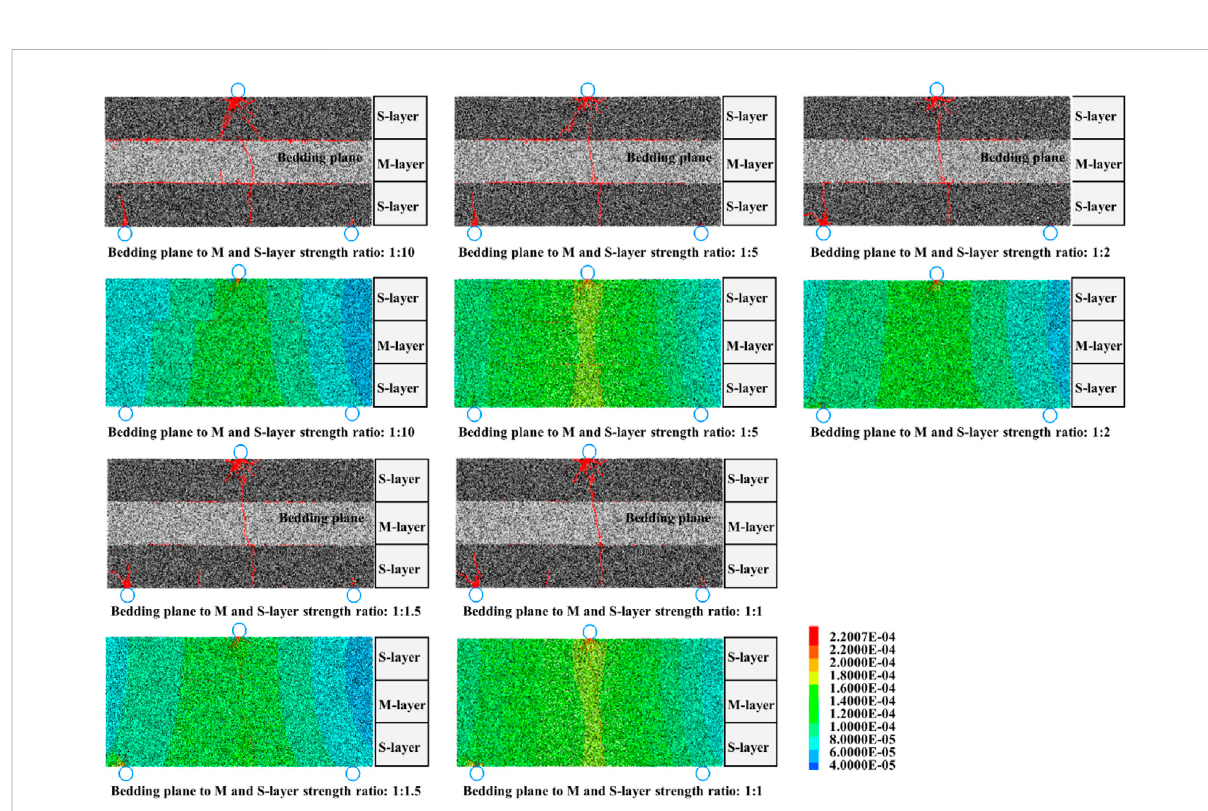
FIGURE 14 Crack propagation paths and surface displacement clouds for different bedding planes strength.